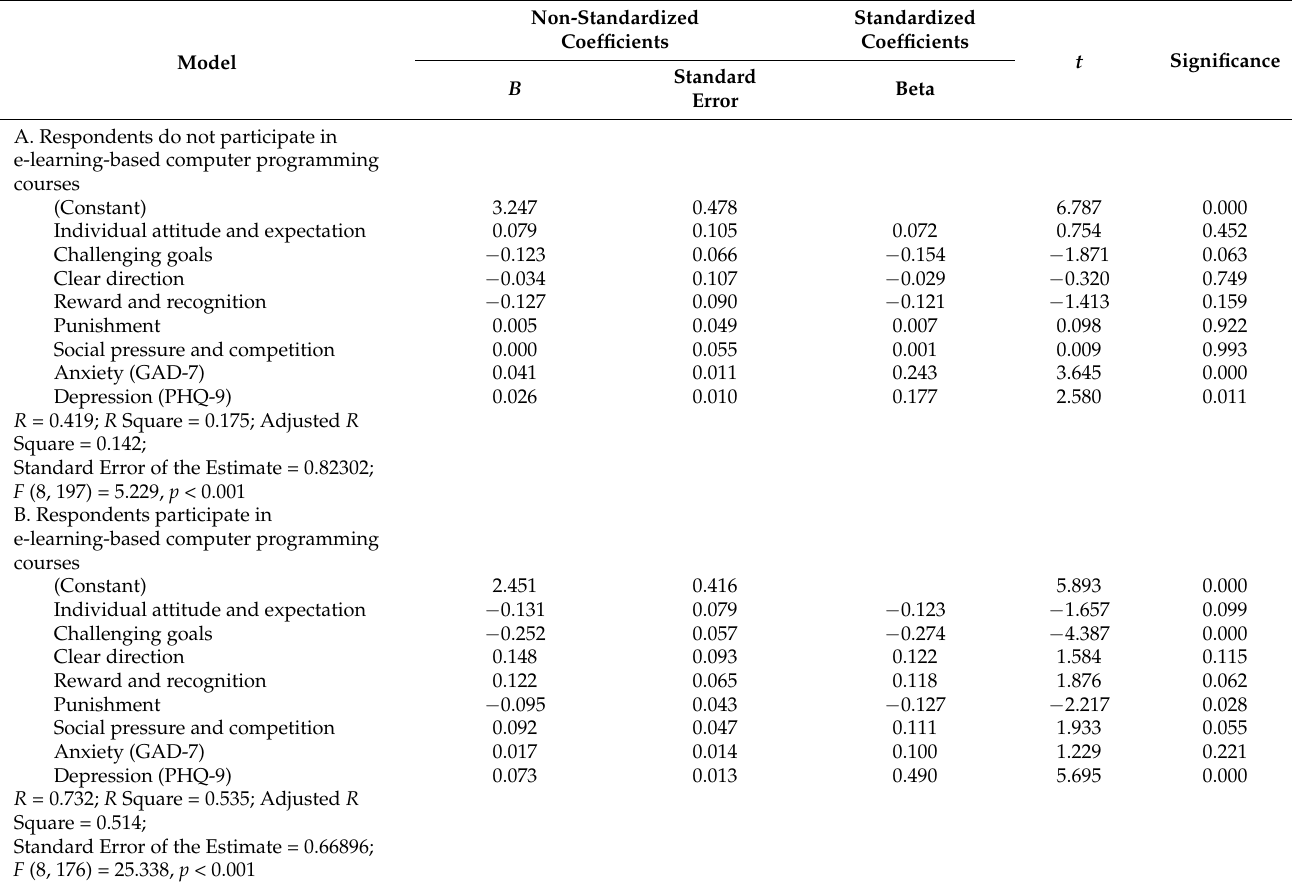
Table 14. Multiple regression models in which the dependent variable is mental fatigue and the predictors are learning motivating factors, anxiety, and